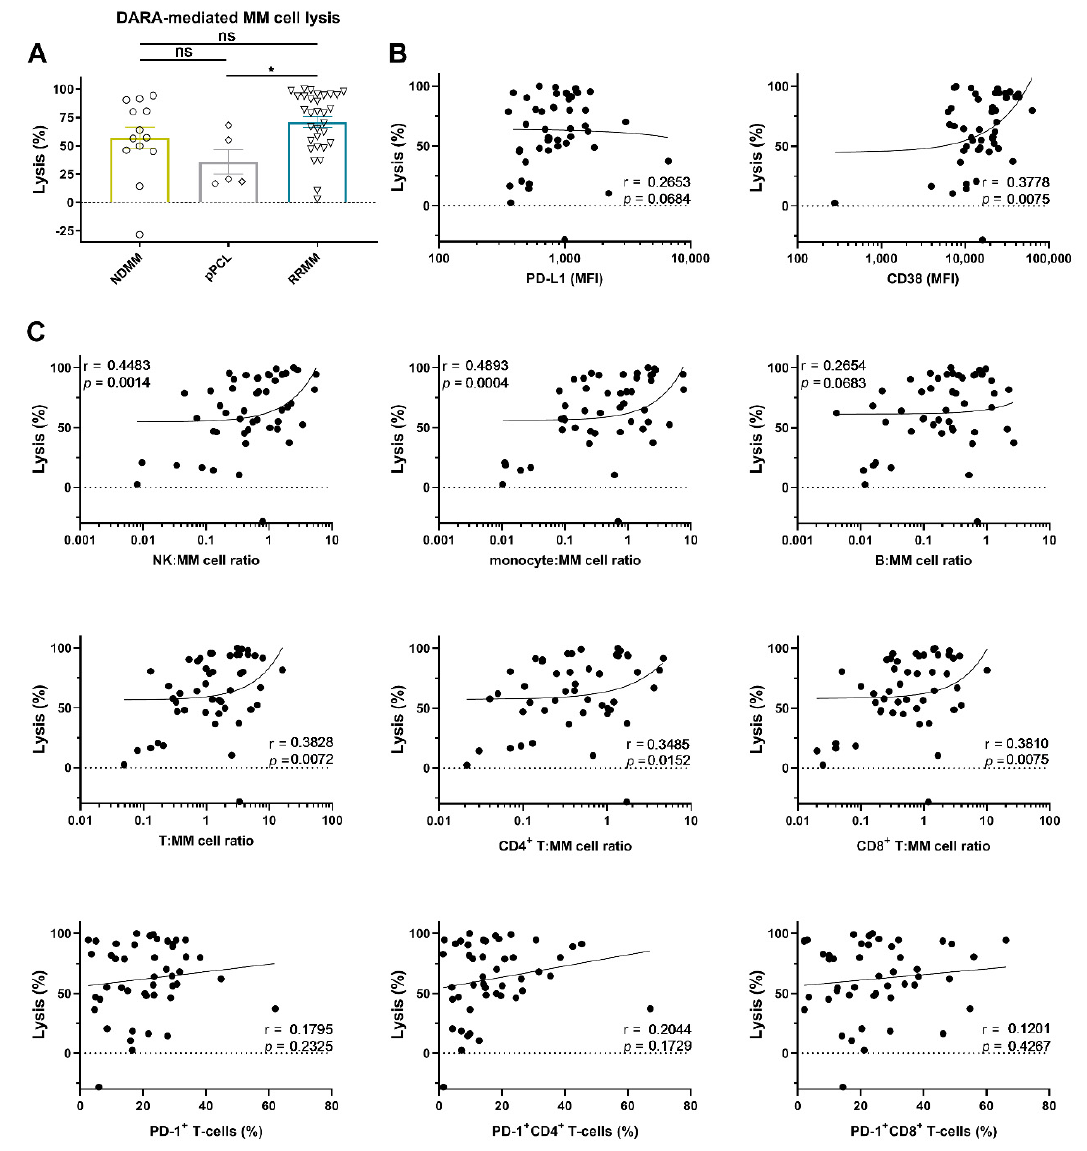
Figure 2. Daratumumab-mediated MM cell lysis in short-term ex vivo cytotoxicity assays. ( A ) BM-MNCs obtained from 13 NDMM, 5 pPCL, and 31 daratumumab-naïve RRMM patients were incubated with daratumumab 10 µg/mL in duplicate for 48 h, after which MM cell-specific lysis was assessed by flow cytometric analysis. Groups were compared using the Mann–Whitney test; data are depicted as individual experiments, with bars representing the mean ± SEM. The correlations between daratumumab-mediated MM cell lysis and ( B ) the baseline tumor characteristics, and ( C ) the immune characteristics, including the effector:target ratios, were calculated using Spearman’s correlation coefficient (r). The median NK-cell:MM cell ratio was 0.64 (range 0.01–5.63); the median monocyte:MM cell ratio was 0.66 (range 0.01–7.70); the median B-cell:MM cell ratio was 0.26 (range